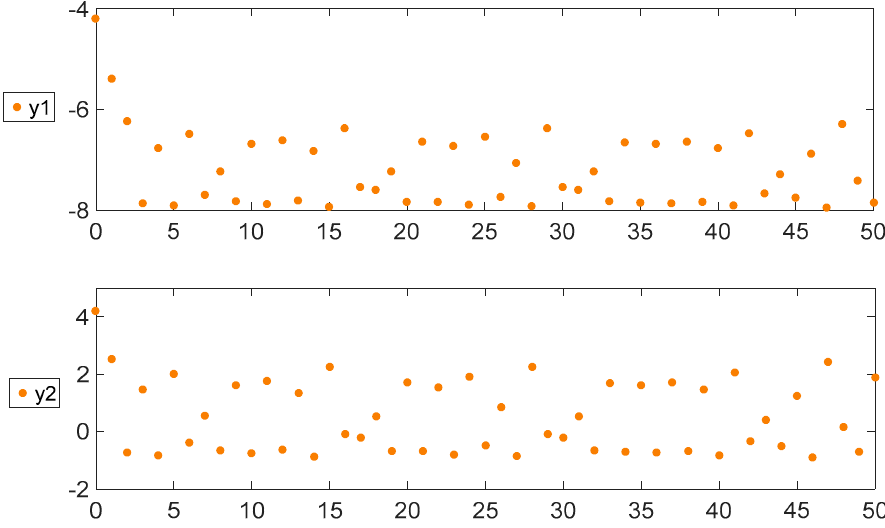
Figure 1. The state responses of the Duffing map chaotic system (before modulation).